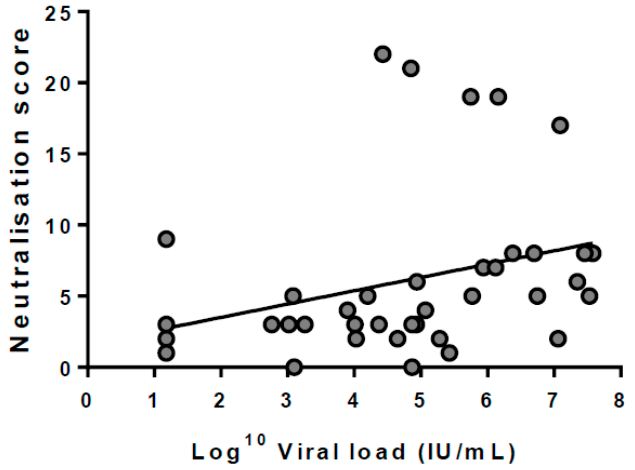
Figure 7. Linear regression analysis between the neutralisation score and peak viral load detected during acute viraemia (IU/mL). Although a modest correlation was found ( r = 0.299), this was not significant ( p = 0.0641).